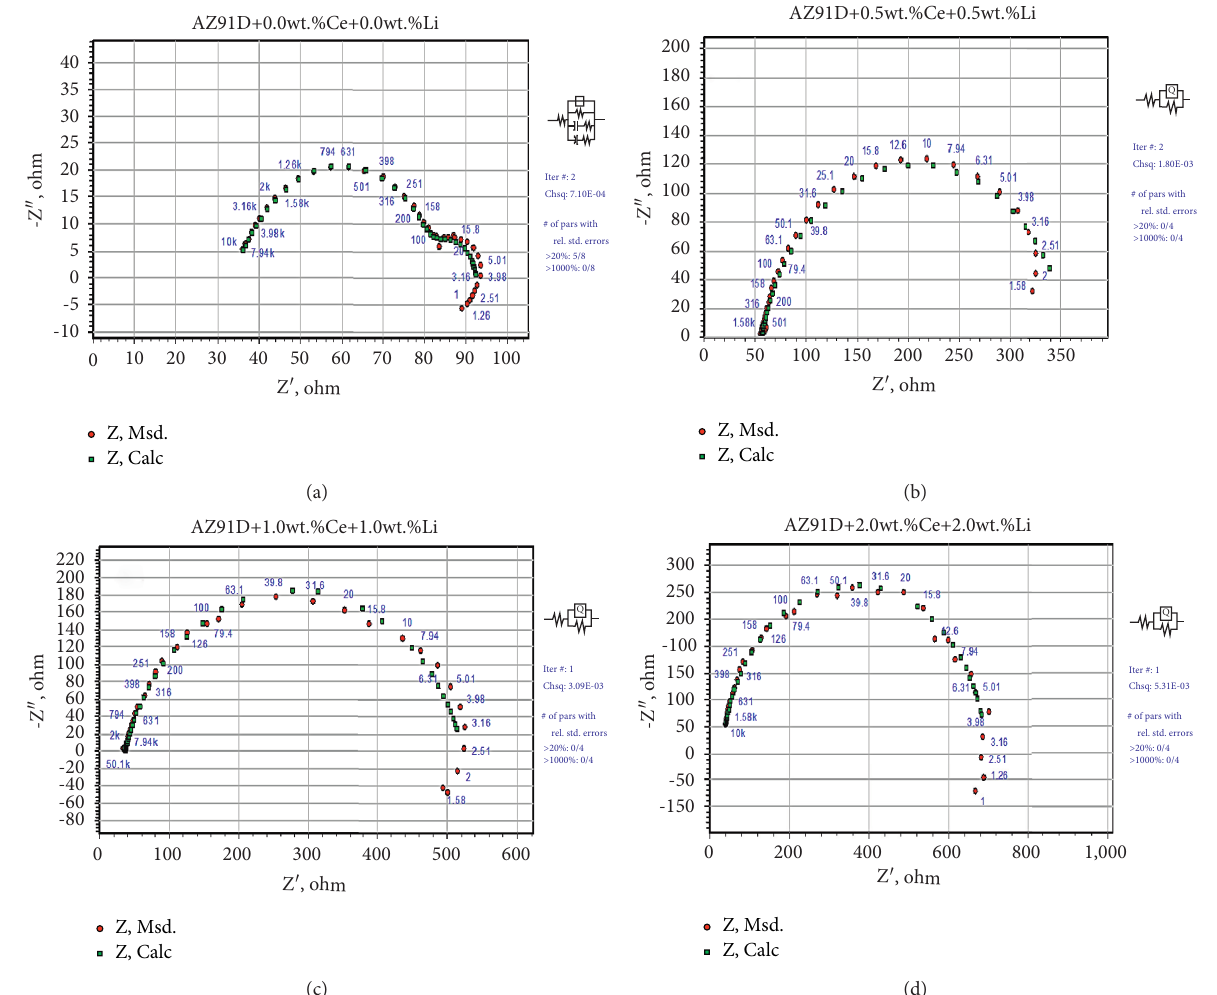
Figure 12: Nyquist plots and Bode impedance plots of as-cast and Ce and Li added AZ91D measured in a 3.5 wt% NaCl solution at their open-circuit